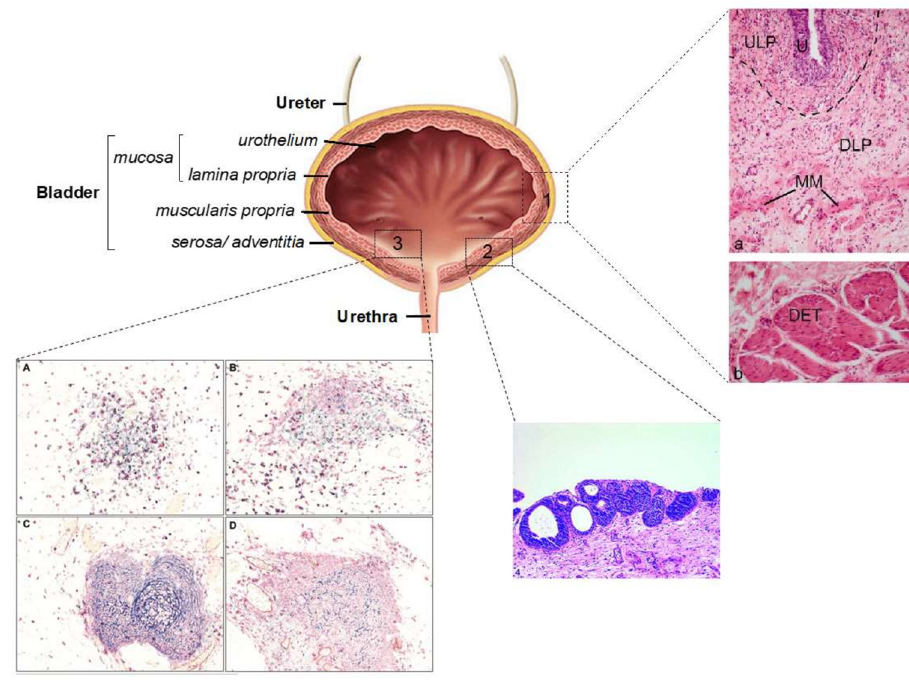
Figure 7. Schematic representation of the main sublayers of the bladder with an amplificated view to show a ( 1 ) Hematoxylin–eosin staining of the ( a ) mucosa of the bladder and ( b ) the muscularis propria . (U) refers to the urothelium, and the lamina propria (LP) is split between the upper lamina propria (ULP) and deeper lamina propria (DLP) with a dashed line, with the muscularis mucosae (MM) below and a separated view of the detrusor muscle (DET), located in the muscularis propria layer [88]. ( 2 ) Histological staining of von Brunn nests. ( 3 ) Multi-IHC view of bladder lymphoid aggregates from type 1 to type 4: CD4+ T cells (green), CD8+ T cells (purple), CD20+ B cells (pink), CD21+ and CD208+ follicular dendritic cells (blue and black, respectively)